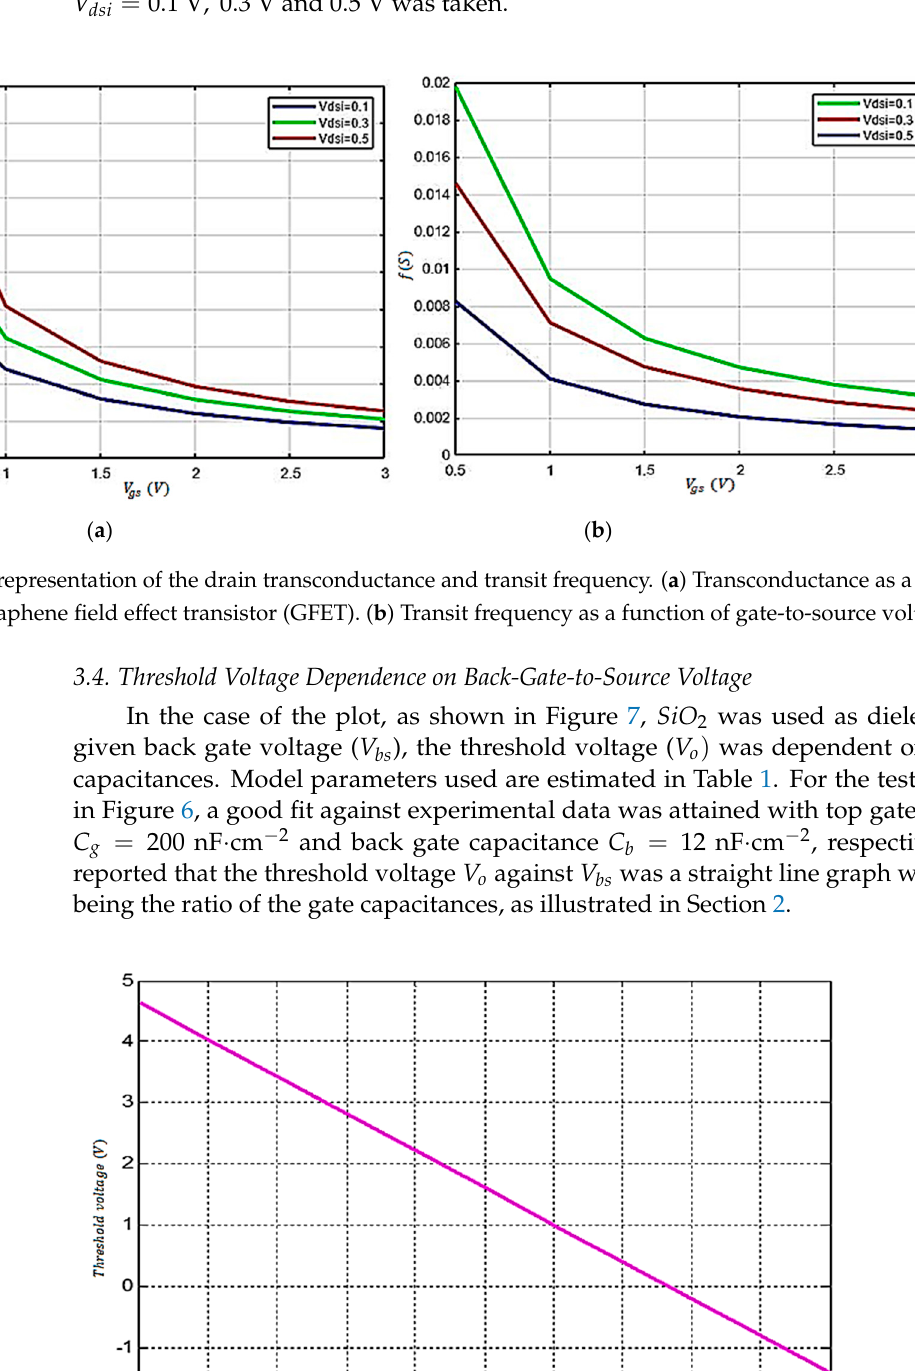
Figure 7. Graphical representation of threshold voltage dependence on back-gate-to-source voltage using silicon dioxide as dielectric.